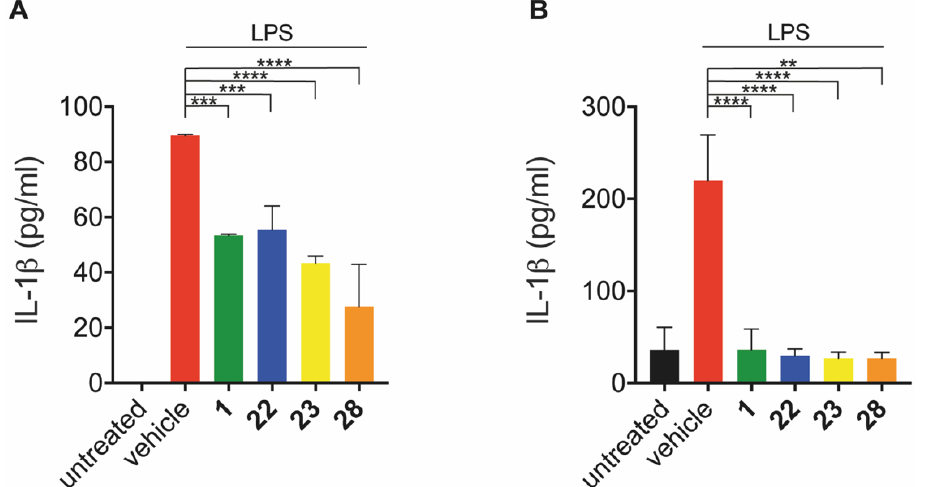
Figure 3. In vivo inhibition of IL-1 β release. ( A ) Exudate and ( B ) plasma levels of IL-1 β from C57BL/6 mice pretreated with compounds or vehicle control as determined by ELISA 4 h after intraperitoneally IP LPS (1 mg/kg) injection, n = 6/group. Data are shown as mean ± SEM. Statistical differences were analyzed using one-way ANOVA: **** p < 0.0001, *** p < 0.001, ** p < 0.01.